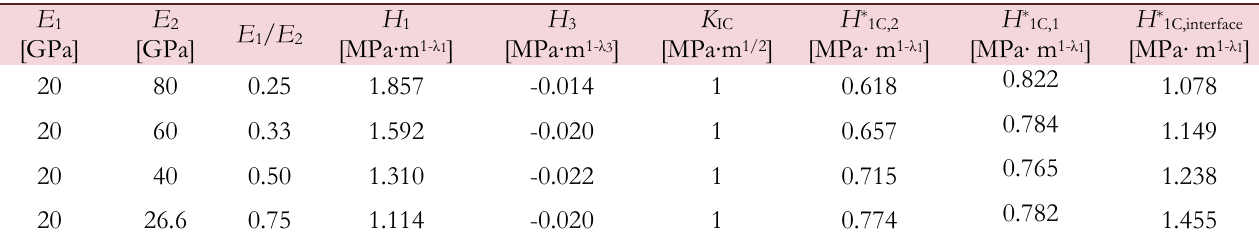
Table 1: Bi-material configurations with resulting GSIFs and values of generalized fracture toughness.